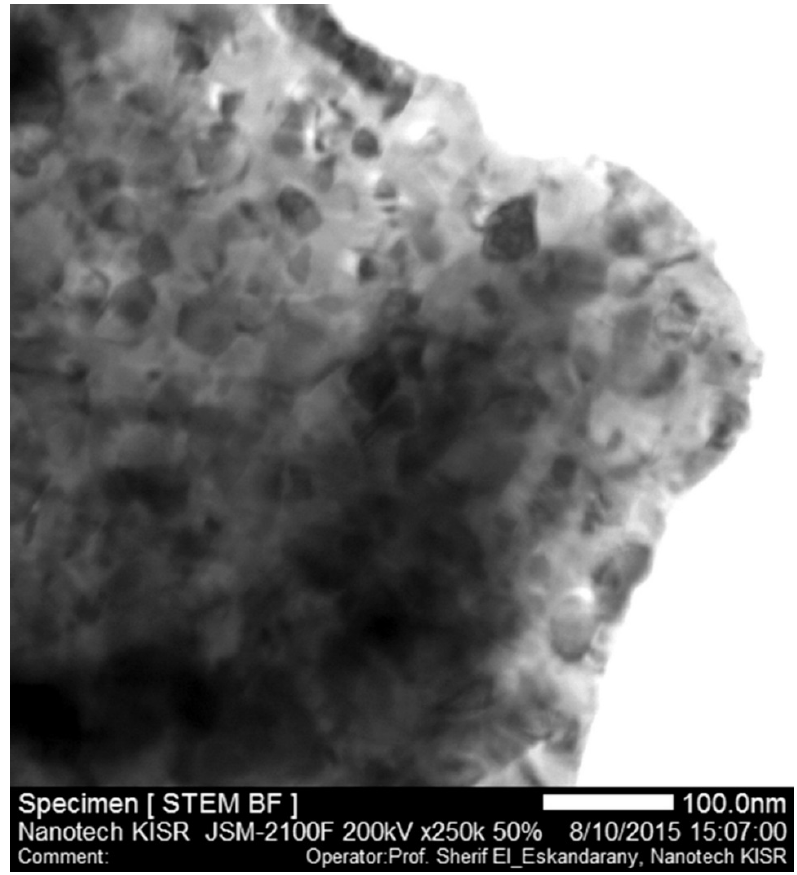
Figure 8. STEM/BF image of ball-milled MgH 2 /5.2TiC/4.6FeCr nanocomposite sample after achieving the PCT hydrogenation/dehydrogenation measurements under hydrogen gas pressure and temperatures ranging between 0 and 10 bar, and 225 and 350 °C, respectively.